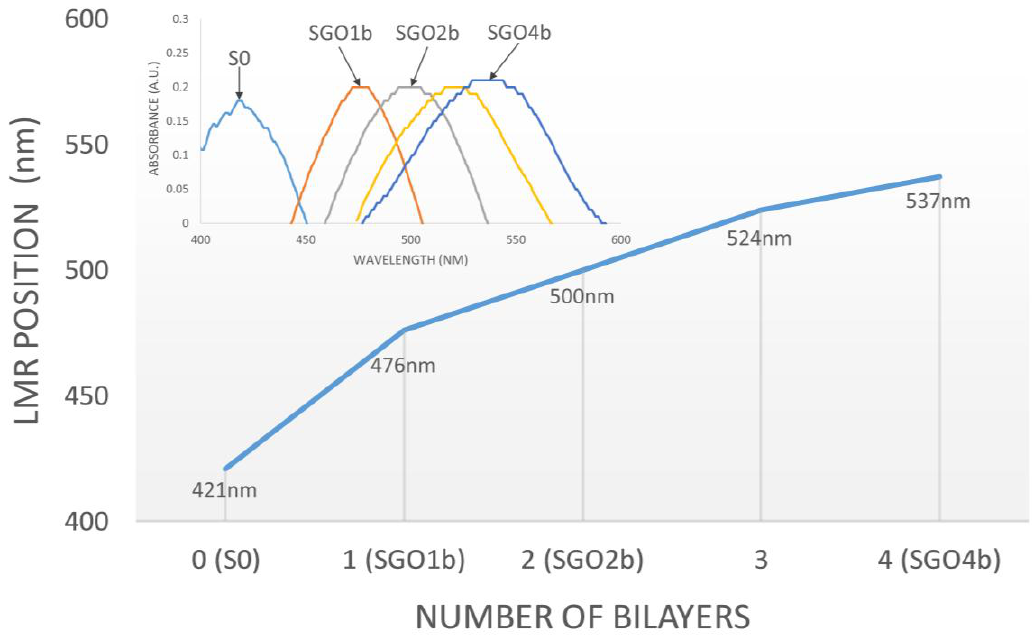
Figure 4. Shift of the LMR absorption peak generated by S0 during the deposition of four bilayers of PEI/GO.